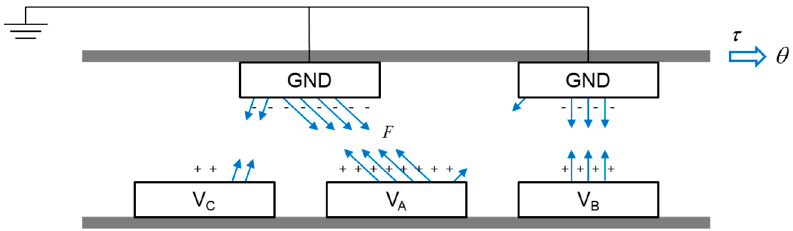
Figure 2. Principle of the electrostatic rotary actuator operations.